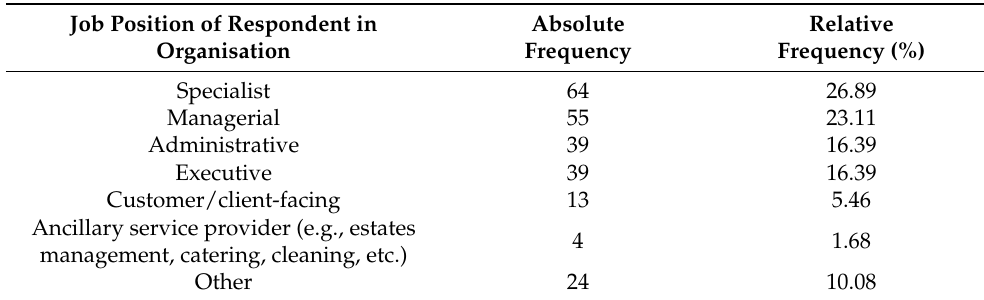
Table 2. Characteristics of the respondents, according to their job position within their organisations (own elaboration, 2021).